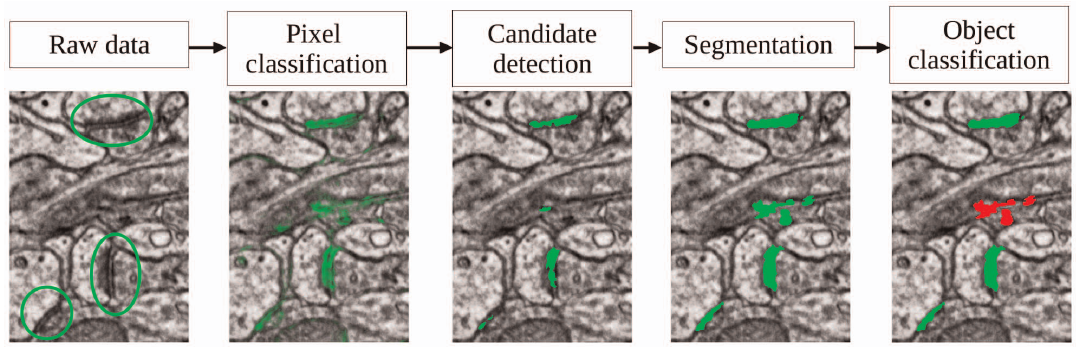
Figure 5. The proposed synapse detection pipeline. Left to right: raw data with 3 synapses, shown in green circles; probability map of the synapse class; detection results; graph cut segmentation results; object classification results, with positively classified objects shown in green and the